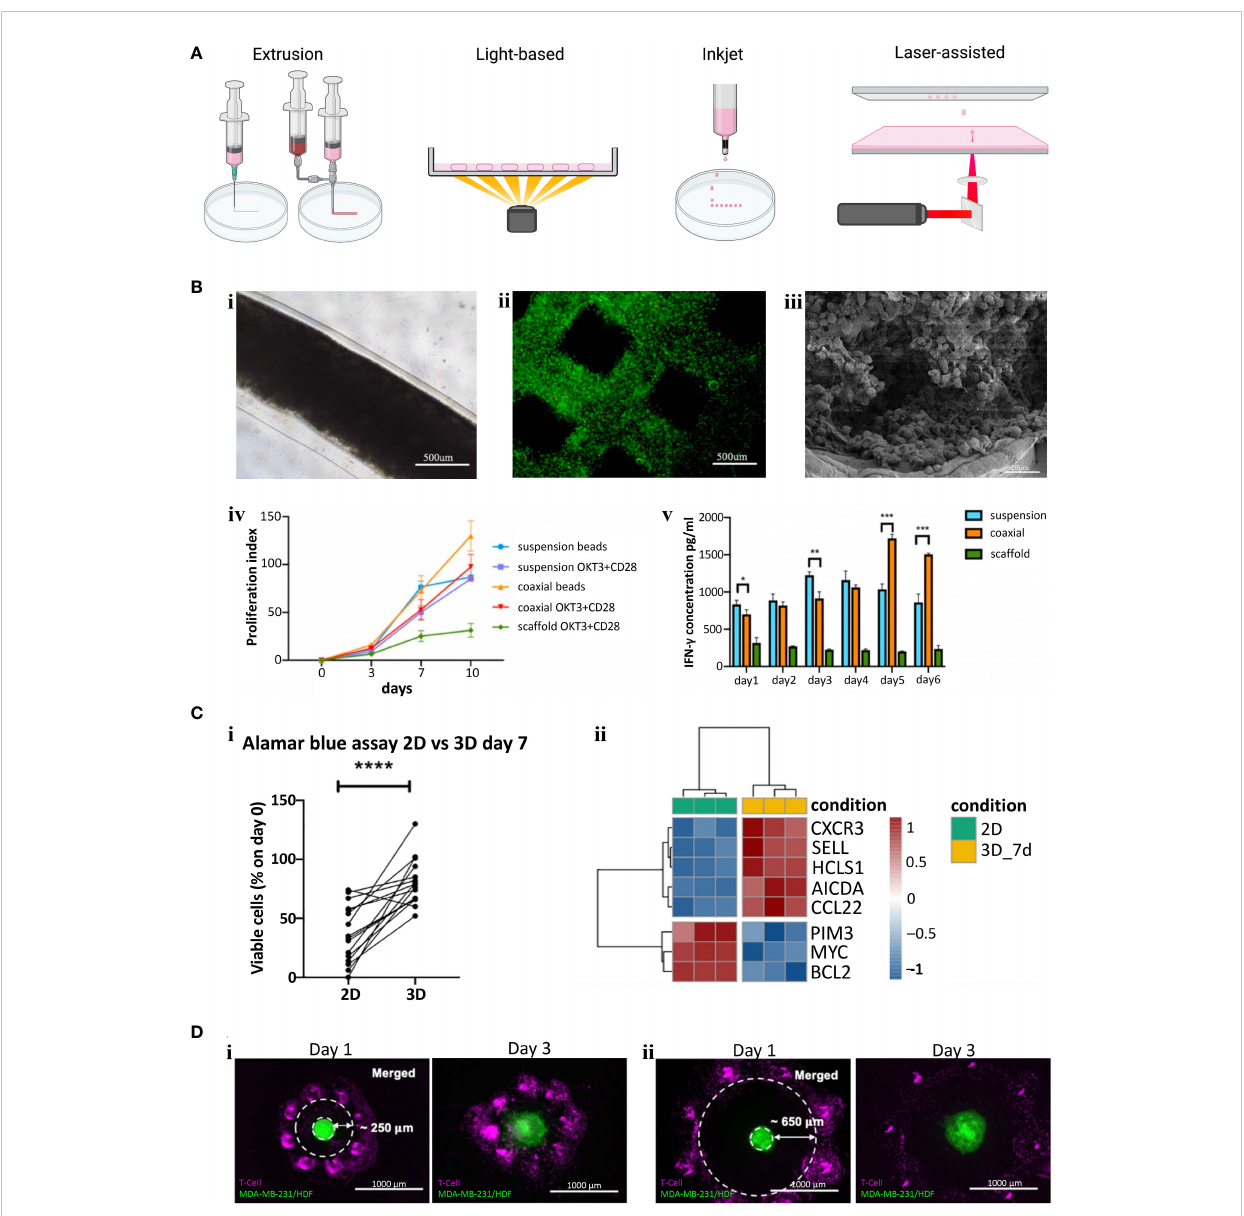
FIGURE 2 (A) Examples of different bioprinting methods. (B) Extrusion bioprinted T cells in gelatin-alginate hydrogel. i) Bright fi eld image of alginate + gelatin coaxial print on day 10. ii) Live/Dead viability stain (Calcein-AM/Propidium iodide) two hours post print. iii) SEM image of coaxial printed fi